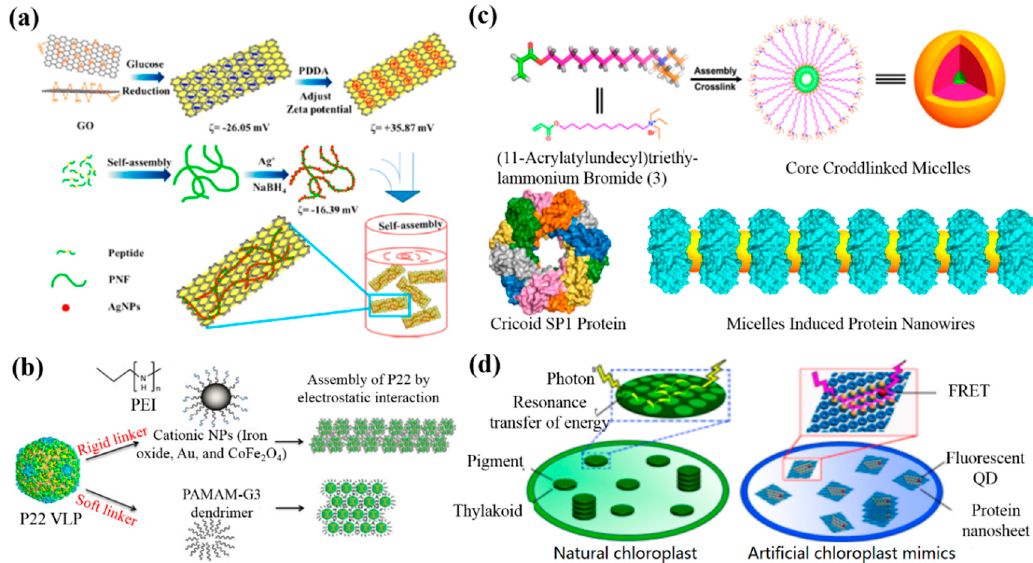
Figure 2. Electrostatic-interaction-mediated self-assembly of biomolecule-based nanomaterials: ( a )